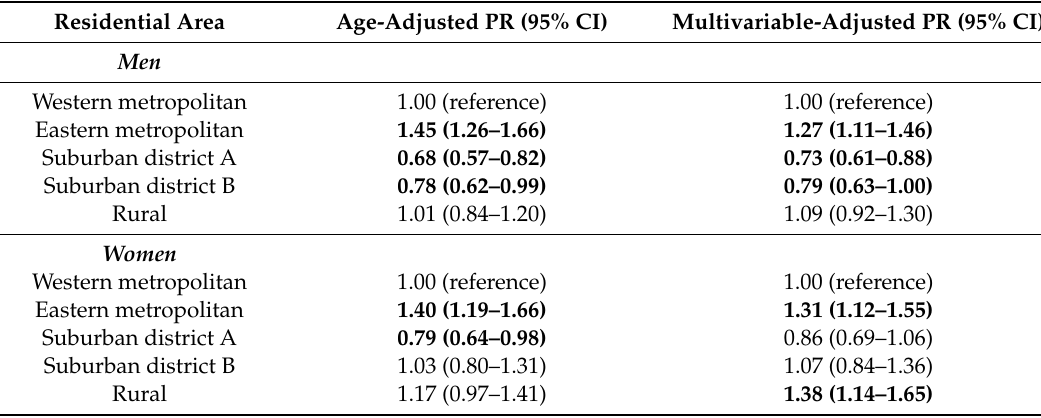
Table 4. The association between living area and